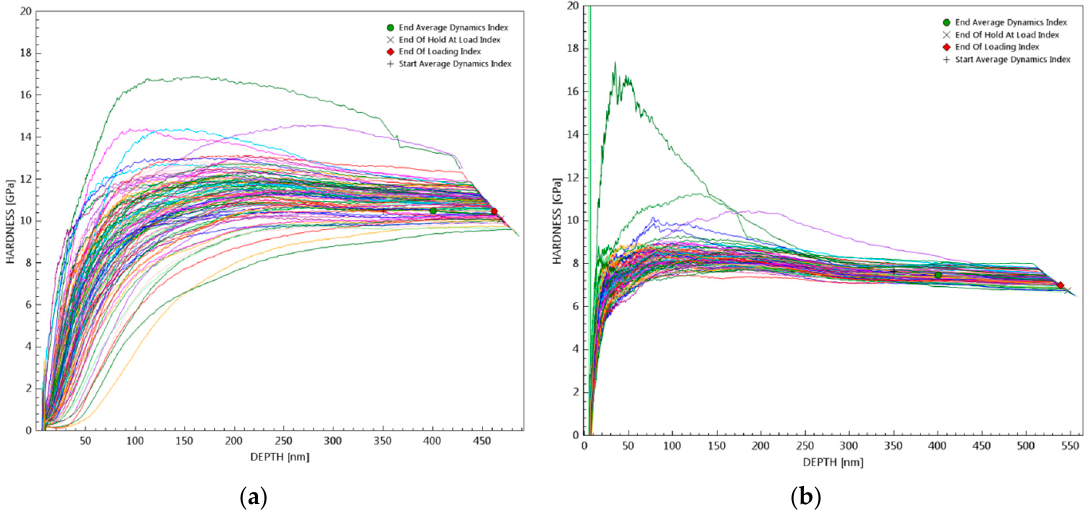
Figure 6. Nano indentation measurements of the polished ( a ) and milled ( b ) sample.